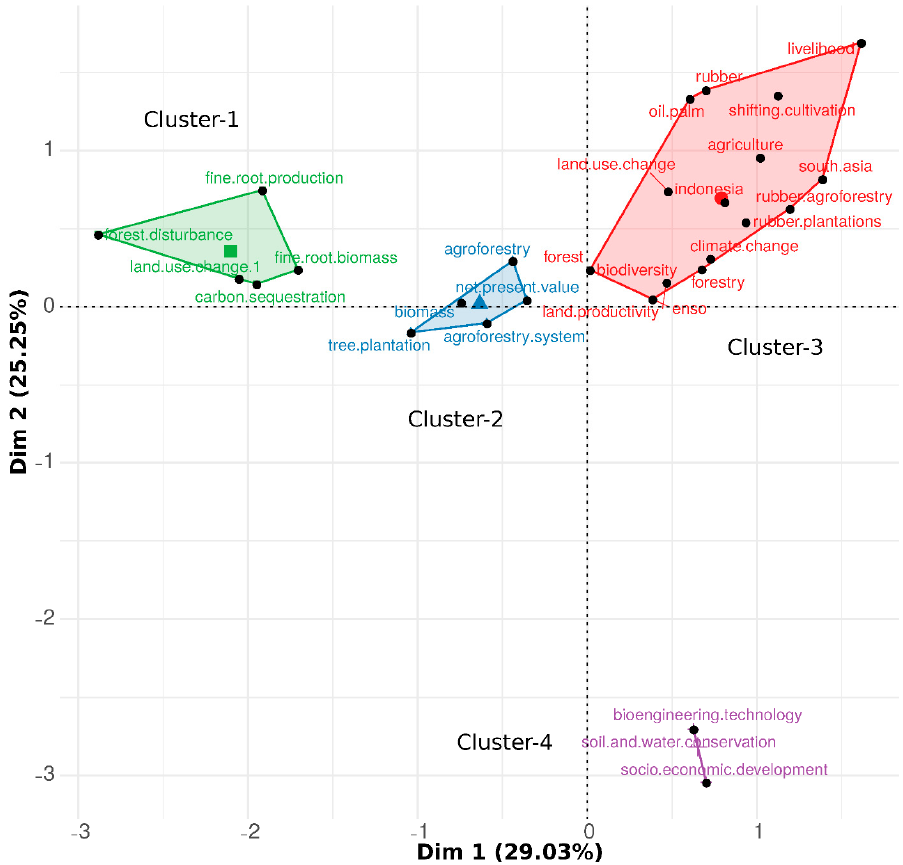
Figure 3. Conceptual structure map of research topics related to agroforestry in S. Asia, prepared using Multiple Correspondence Analysis of author keywords. (Dimension 1 and 2 on X and Y axes, respectively).